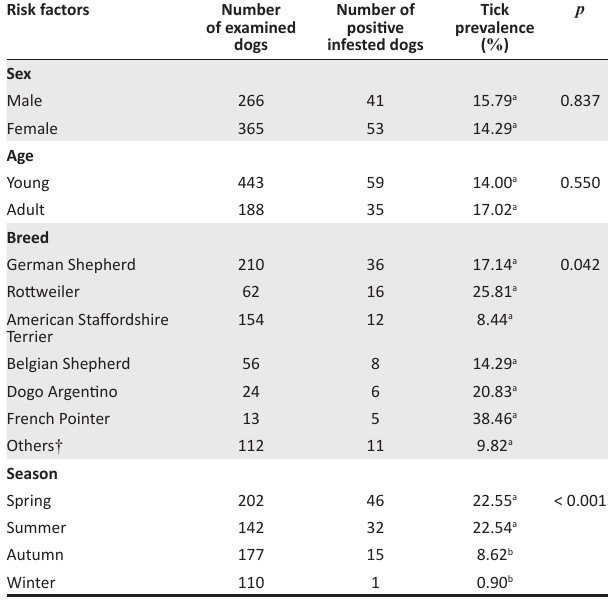
FIGURE 2: Seasonal abundance of ticks ( Rhipicephalus sanguineus , Rhipicephalus bursa , Rhipicephalus turanicus and Ixodes ricinus ) found on owned dogs in the Bejaia province (2016–2017). TABLE 5: The variation of the prevalence of tick infestation in dogs with related risk factors (sex, age, breed and season) in the Bejaia